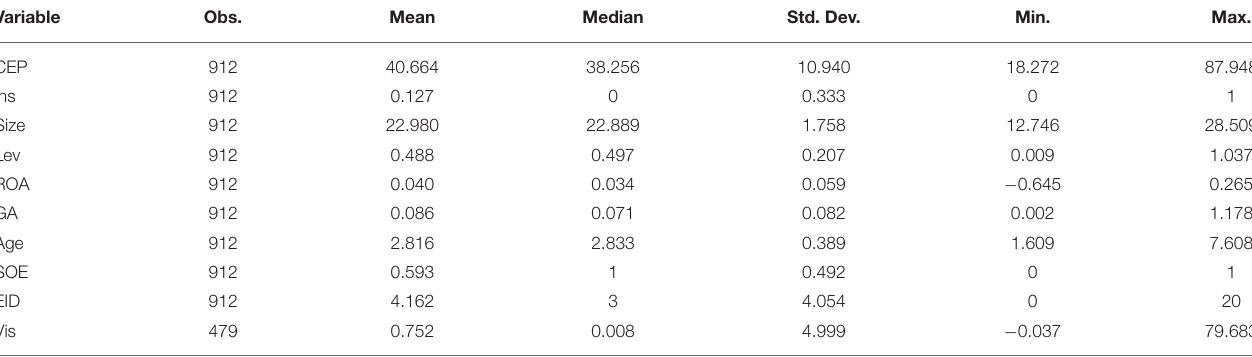
TABLE 2 | Descriptive statistics of variables. Variable Obs.